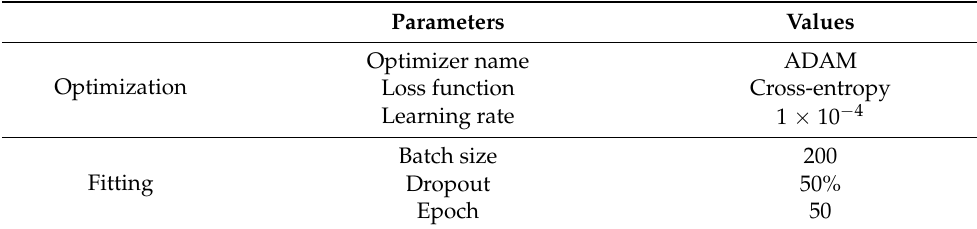
Table 6. Training hyperparameter